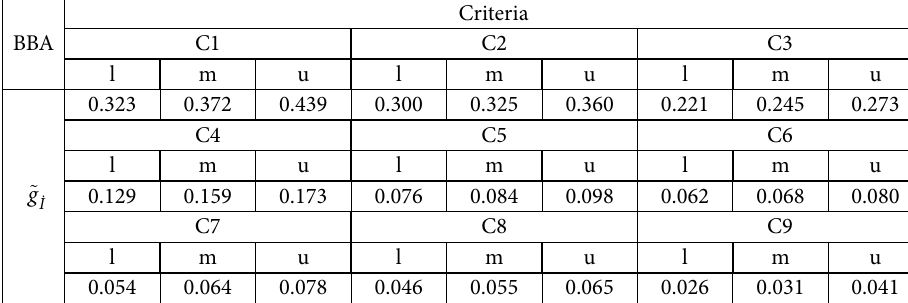
Table 11. Border approximation area matrix (BAA)